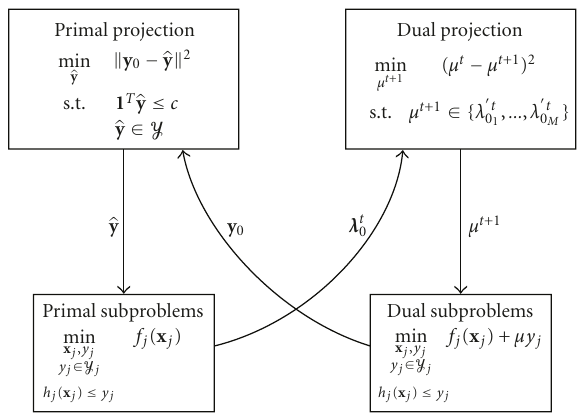
Figure 3: Flow diagram of the coupled-decompositions method.